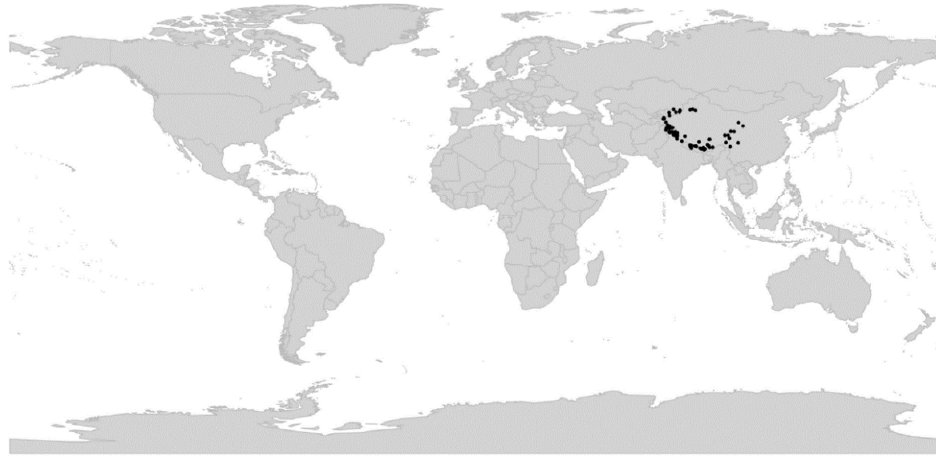
Figure 18. Global distribution of Viola sect. Himalayum